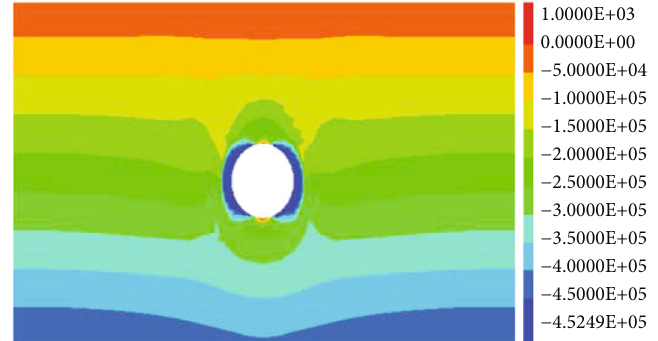
Figure 17: Vertical stress cloud after support.